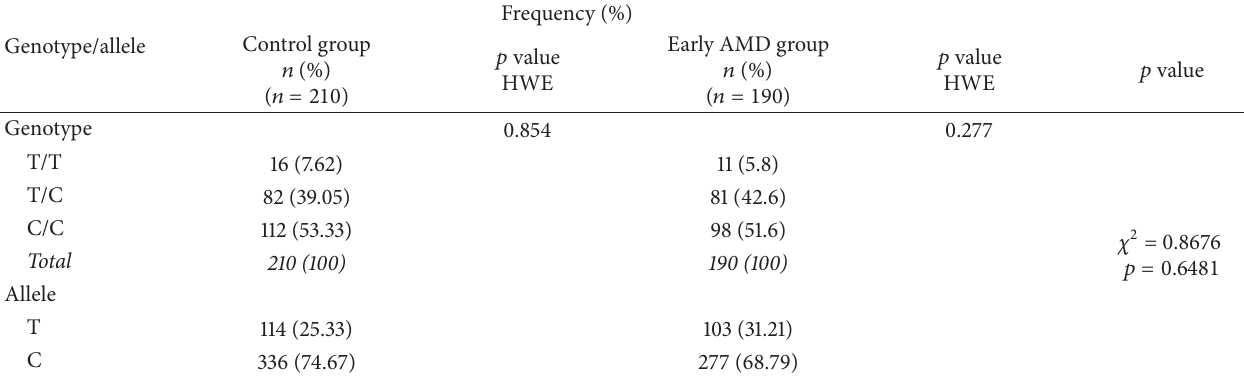
Table 2: Frequency of the CYP4F2 rs2108622 genotypes in the patients with early AMD and in the control group.